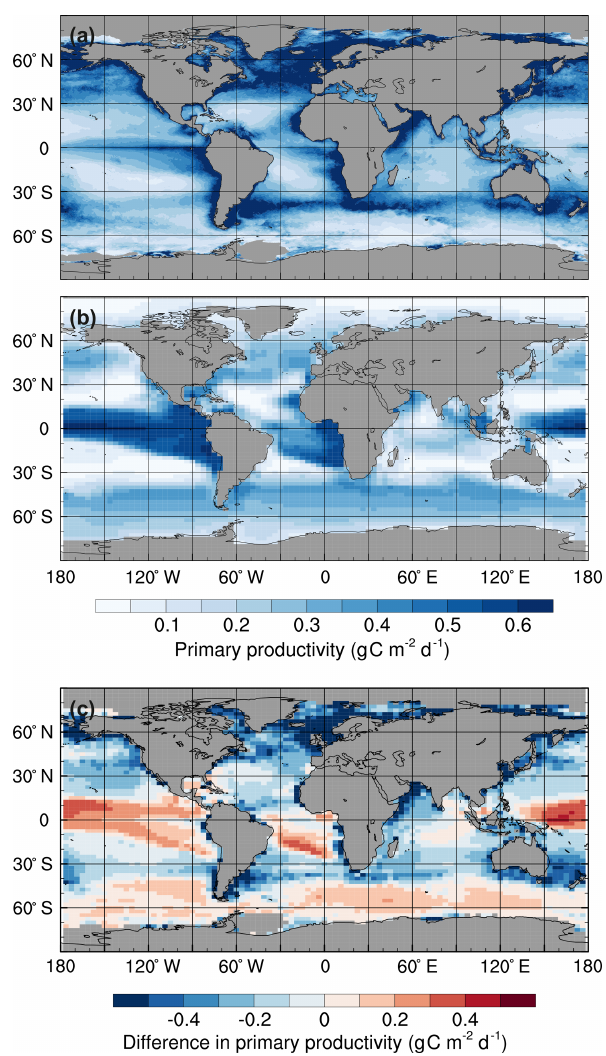
Figure 1. Mean annual surface primary productivity: (a) ob- servations estimated from surface chlorophyll concentrations us- ing the Vertically Generalised Production Model (Behrenfeld and Falkowski, 1997), (b) the std simulation in the 1990s, and (c) simulated minus observed. Monthly mean primary pro- ductivity data were obtained from the Oregon State University Ocean Productivity website (http://www.science.oregonstate.edu/ ocean.productivity, last access: 23 December